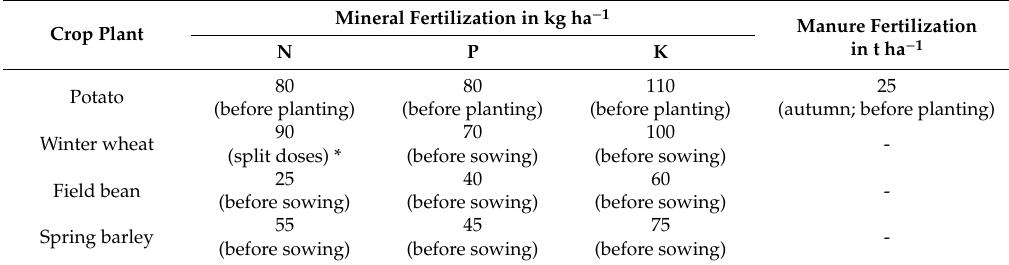
Table 3. Fertilization applied in the conventional system.